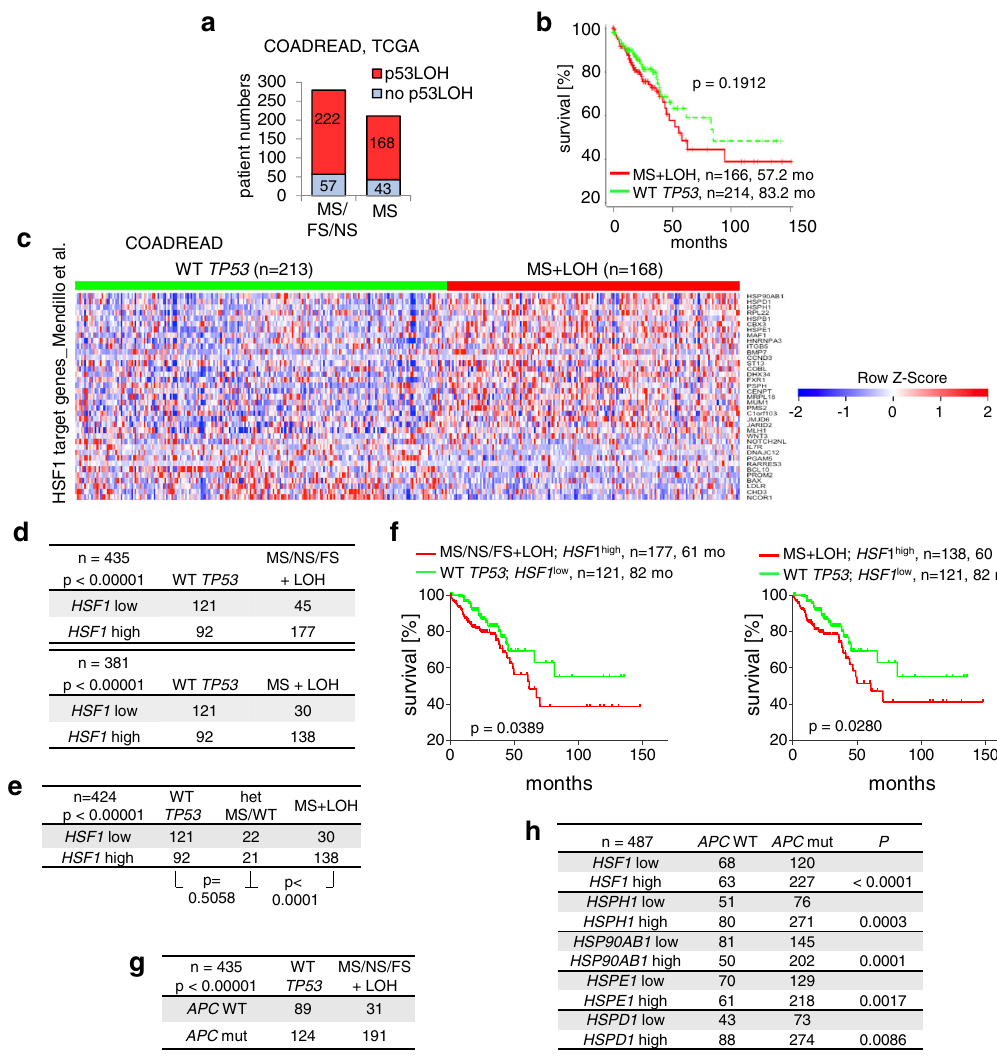
Fig. 6 In human colorectal cancers p53LOH combined with missense mutp53 shortens patient survival and upregulates HSF1 activity. a – h Data from colorectal adenocarcinoma patients. COADREAD, TCGA dataset. a Tumor samples strati fi ed for p53LOH versus no-p53LOH and grouped for either all TP53 mutations (MS missense, FS frameshift, NS nonsense) versus missense mutations-only (MS). p53LOH samples (shallow deletions) were determined by TP53 copy number alterations. Numbers in columns indicate patient numbers. b Survival curve of CRC patients harboring homozygous WT TP53 versus patients harboring missense (MS) p53 mutations plus p53LOH (shallow deletions). Number of patients and mean survival in months as indicated. Kaplan – Meier statistic, two-sided, log-rank test, p = 0.19. Note that TCGA data contains insuf fi cient numbers of heterozygous patients (mutp53/ + ) with clinical data, precluding statistical survival analysis. c Heatmap of HSF1 target genes from colorectal carcinomas. Patients with homozygous TP53 + / + (WT TP53 ) versus patients with TP53 missense (MS) mutations plus p53LOH (MS + LOH). All genes with t test p values <0.001 were plotted as heatmap rank- ordered by their relative expression change from top to bottom. Colors represent Z -scores for each gene from blue (downregulated) to red (upregulated) expression. A homemade HSF1 target gene panel from Mendillo et al. was used 46 . d Correlation between HSF1 mRNA expression and p53 mutational status in colorectal carcinomas. Patients with homozygous TP53 + / + (WT TP53 ) versus patients with either MS/FS/NS + LOH (top, n = 435 patients) or patients with MS + LOH (bottom, n = 381 patients) with regard to their HSF1 expression. Fisher ’ s exact test, two-sided. e Loss of the remaining WTp53 allele correlates with high HSF1 mRNA expression in colorectal carcinomas. Patients with WT TP53 versus MS/WT (HET) versus MS + LOH. Chi-square statistic, n = 424 patients. Fisher ’ s exact test, two-sided, between WT versus HET and between HET versus MS + LOH. f Survival of patients with MS/NS/FS + LOH (left) or MS + LOH (right), and HSF1 high versus patients with WT TP53 and HSF1 low . Number of patients, mean survival in months and Kaplan – Meier statistic log-rank test, two-sided, as indicated. g , h Correlation between APC mutations and p53 mutational status ( g ) or mRNA expression of HSF1 and HSF1 target genes ( h ). Analysis as in d . Patient numbers as indicated. Fisher ’ s exact test,